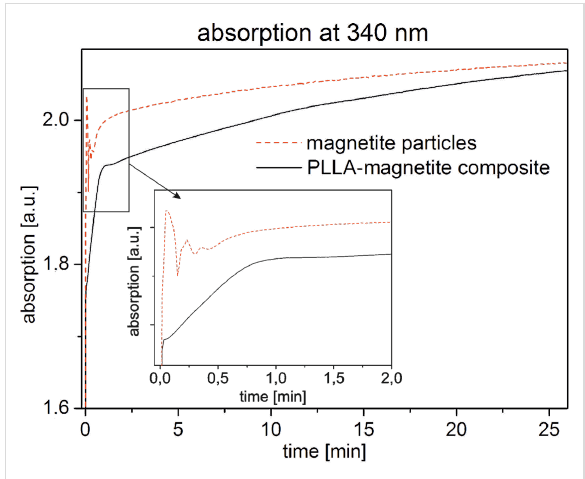
Figure 4: Time-dependent UV – vis adsorption measurement moni- toring the formation of the FeCl(H 2 O) 52+ complex upon addition of HCl to pristine magnetite particles and magnetite-decorated PLLA particles. The formation process in case of the PLLA–magnetite particles is slightly retarded, indicating that an additional PLLA layer is covering the